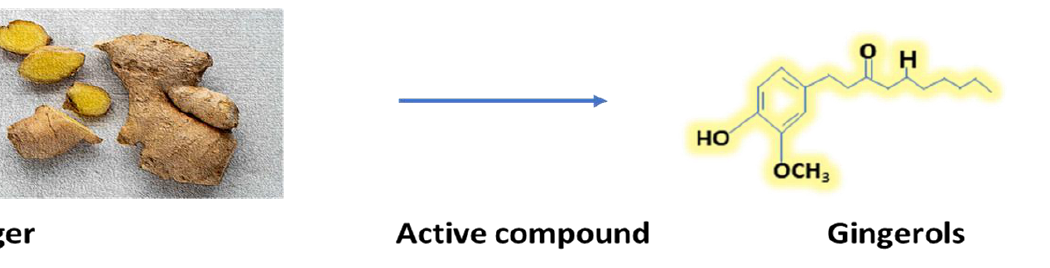
Figure 8. Most active compound of ginger (Gingerols).